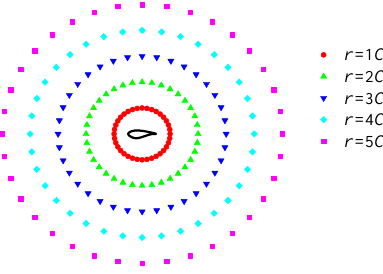
Figure 14. The noise monitoring points of the airfoil.